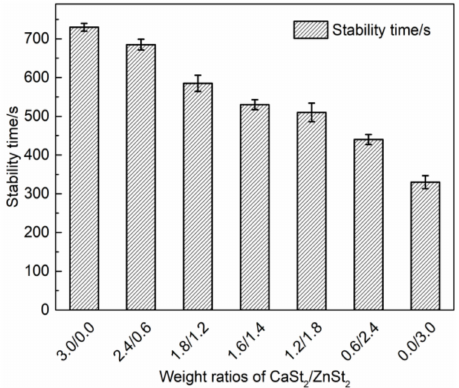
Figure 9. The effects of thermal stability time for PVC with different proportion of CaSt 2 /ZnSt 2 thermal stabilizers at 180 ◦